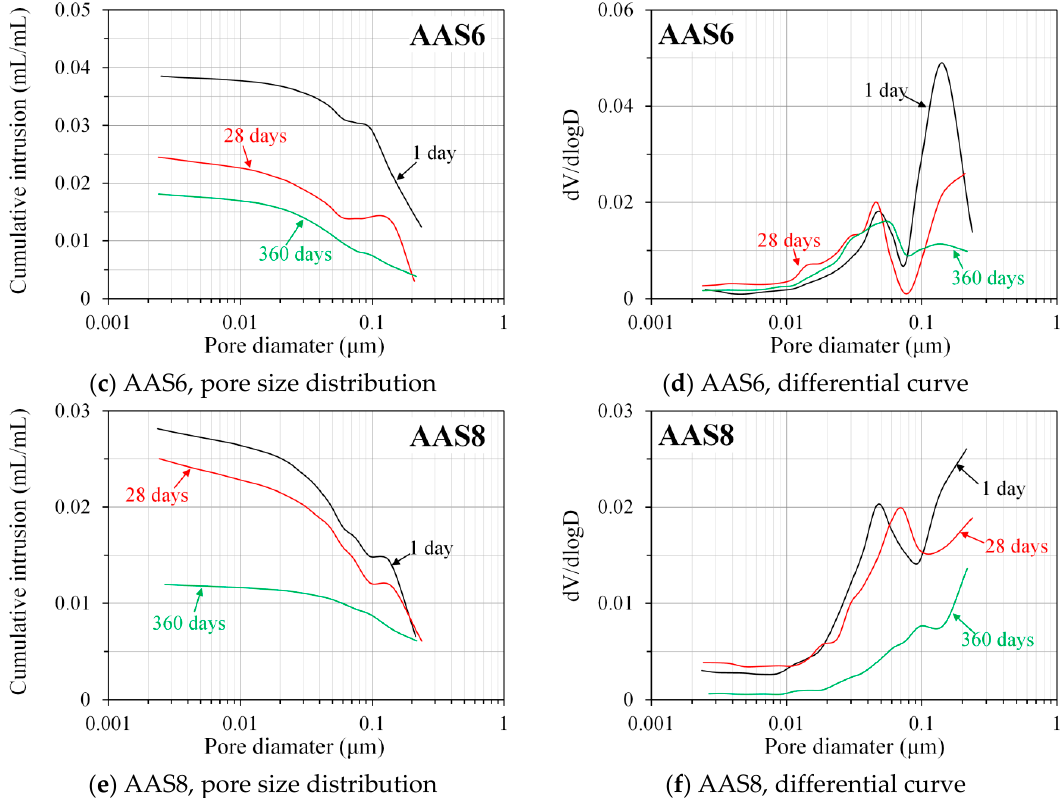
Figure 10. Pore size distribution and differential curves, derived from nitrogen adsorption, for AAS4 ( a , b ), AAS6 ( c , d ), and AAS8 ( e , f ) at 1, 28, and 360 days (the nitrogen adsorption data at 7 and 180 days are shown in Figure S2, as included in the Supplementary Materials). In the graphs, P 1 and P 2 are the first and second peak, respectively. AAS indicates alkali-activated slag, the number following AAS refers to the weight percentage of Na 2 O with respect to slag. For all samples, the water to slag ratio was 0.4 and the curing temperature was 20 °C.